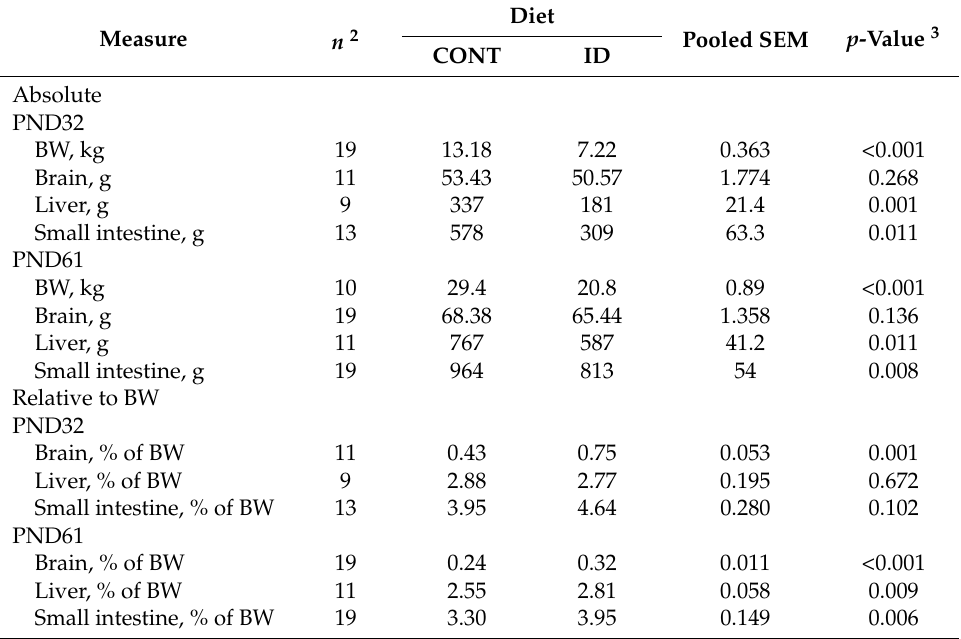
Table 2. Organ characteristics of pigs differing in early-life iron status 1